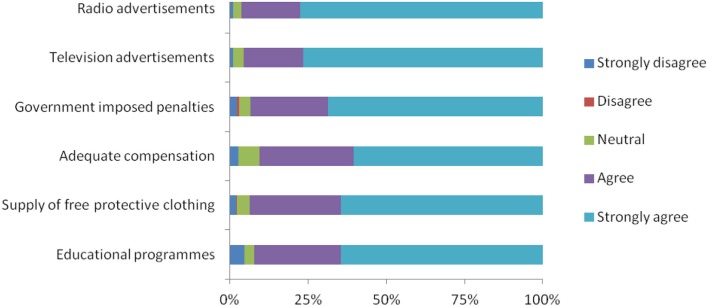
Major interventions for facilitating the adoption of protective behaviors and practices.